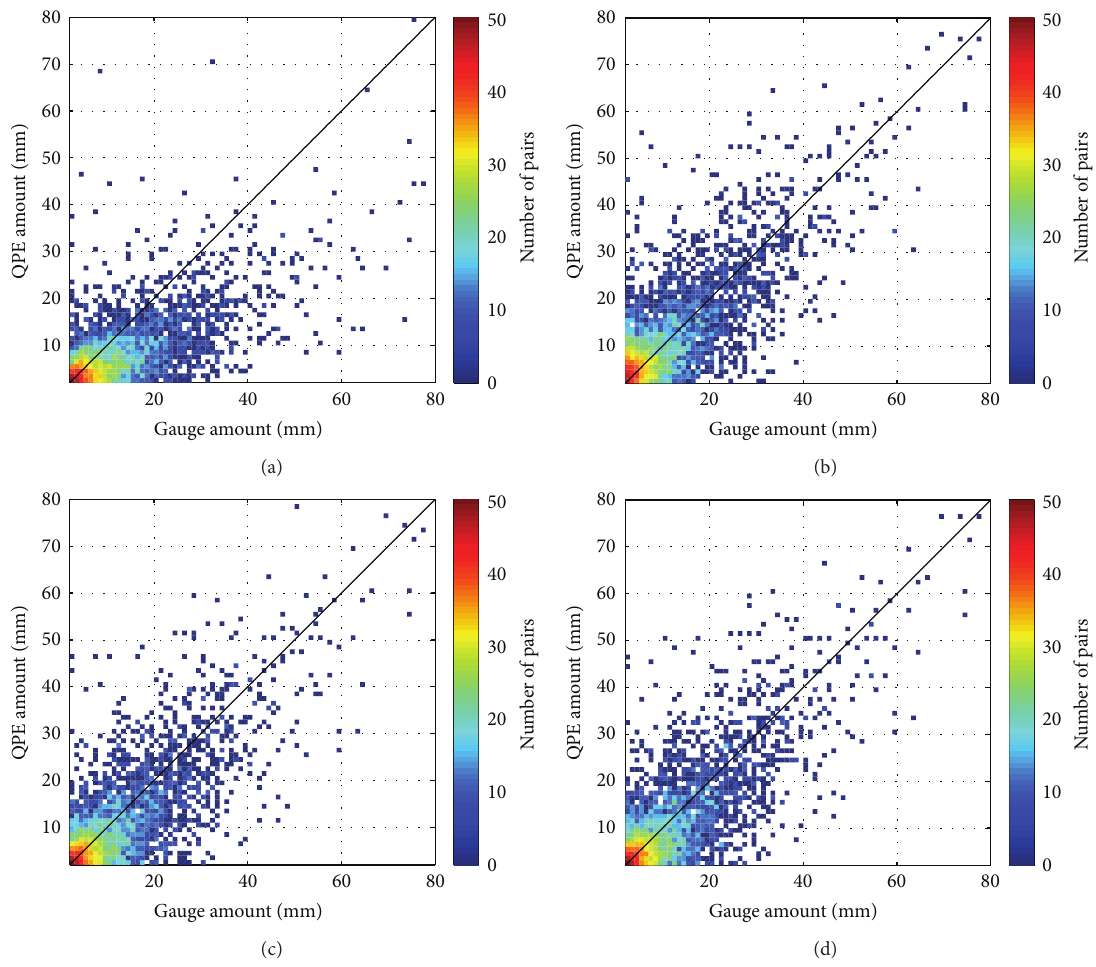
Figure 14: The comparison results between gauge network observations and QPE using (a) RZ , (b) RKDP, (c) CA, and (d) VCCA. 5-day data from summer precipitation (11 ∼ 15 July 2011) are selected, and a total of 6885 QPE-gauge pairs are used in the